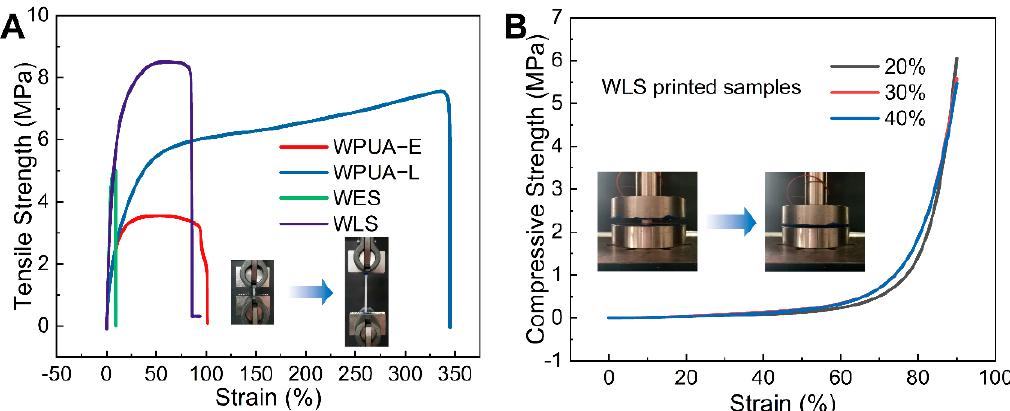
Figure 8. ( A ) Tensile properties of WPUA − A, WPUA − L, WES and WLS films. ( B ) Compression properties of WLS samples with 20%, 30% and 40% filling ratio, respectively.